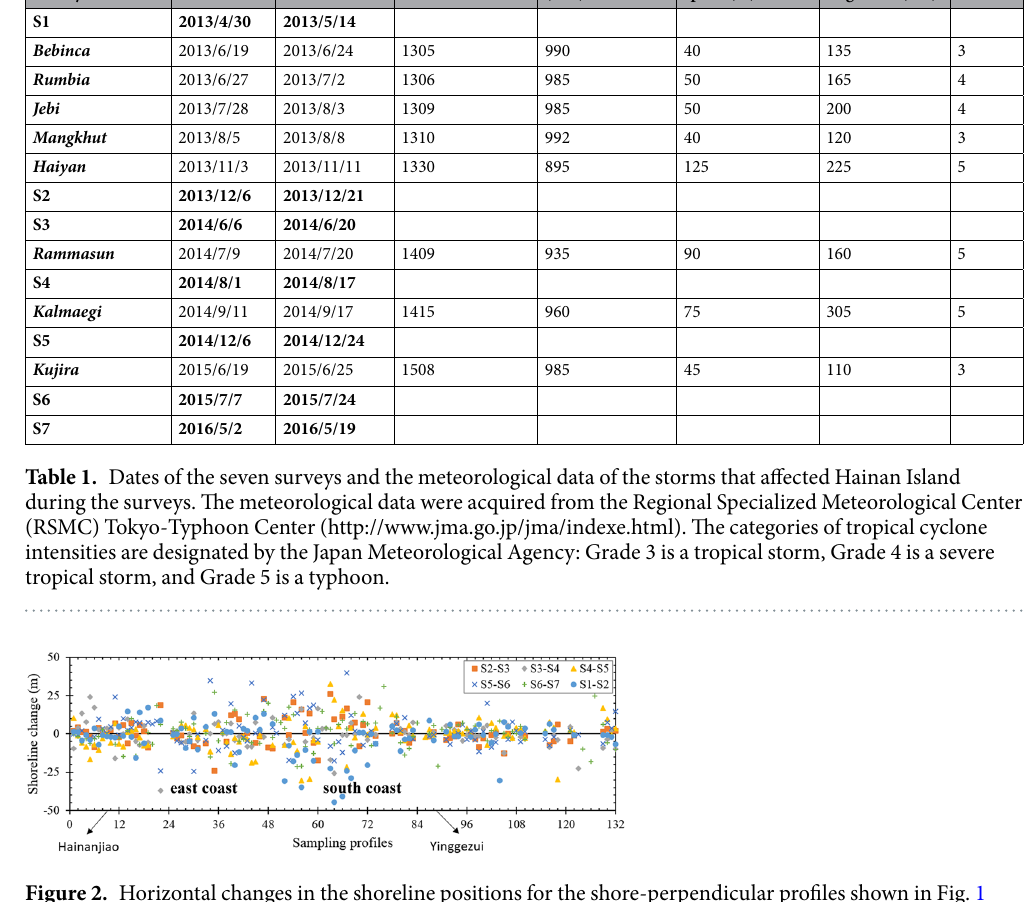
Figure 2. Horizontal changes in the shoreline positions for the shore-perpendicular profiles shown in Fig. 1 during the 6 survey periods. Positive values represent accretion, negative values represent